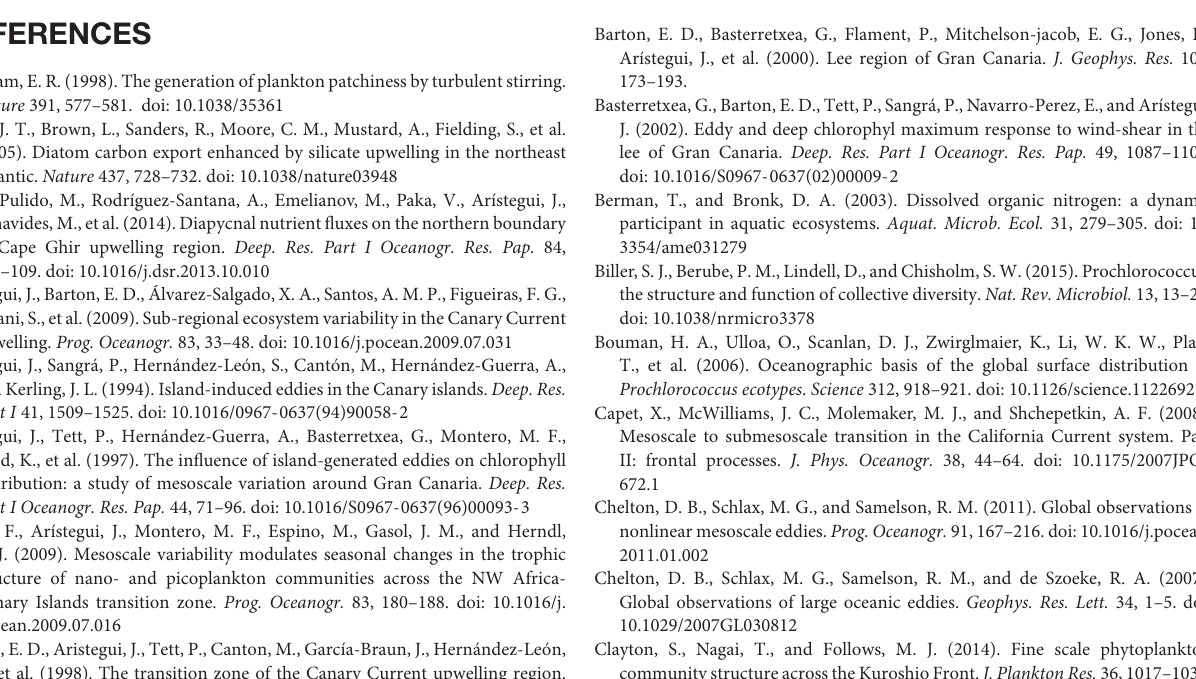
Supplementary Figure 1 | Sea surface temperature ( ◦ C) time series for (A) May 09th 2011 (0 h), (B) May 10th 2011 (24 h), (C) May 11th 2011 (48 h), and (D) May 12th 2011 (72 h). Salinity contours are superimposed to SST maps. Black dots with red borders indicate stations positions. Red dot indicates Gando airport location. Supplementary Figure 2 | Vertical sections of Turner angles (T U ; ◦ ) for 0 h (A) , 24 h (B) , and 72 h (C) . Stations are indicated in the upper part of the plot. Dashed black line indicates the mixed layer depth. Sampling depths are represented by gray dots. Angles between − 90 and − 45 are characteristic of diffusive mode; between − 45 ◦ and 45 ◦ is called doubly stable mode; weak salt fingers mode from 45 ◦ to 70 ◦ and salt finger mode for angles larger than 70. Supplementary Table 1 | Values of nutrient gradients (g NOx ; mmol · m − 4 ), vertical eddy diffusivity (K z ; m 2 · s − 1 ), nutrient fluxes (F NOx ; mmol · m − 2 · d − 1 ) below the MLD for all sampled